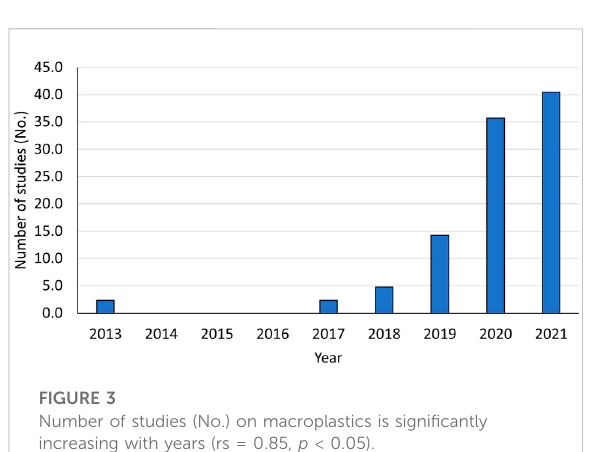
FIGURE 3 Number of studies (No.) on macroplastics is signi fi cantly increasing with years (rs = 0.85, p <